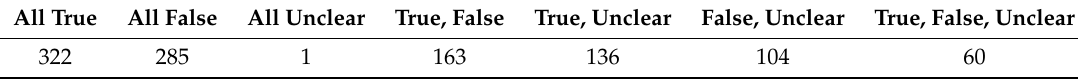
Figure A5. A Venn diagram of agreement of classification among experts. This graphic shows how many and which EICs were classified as "positive" and how often the experts partly or completely agreed upon this classification. EICs that have been classified as "inconclusive" have been left out. Table A3. Expert agreement on EIC classification